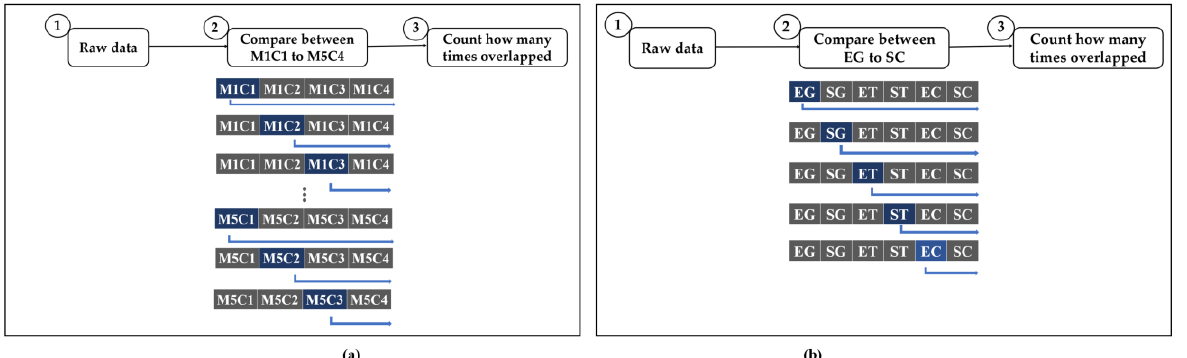
Figure 12. Overlapping algorithm overview. Each method generates overlap relations as well as threads based on the results. ( a ) Comparison between human-based and machine-based algorithm ( b ) Our proposed